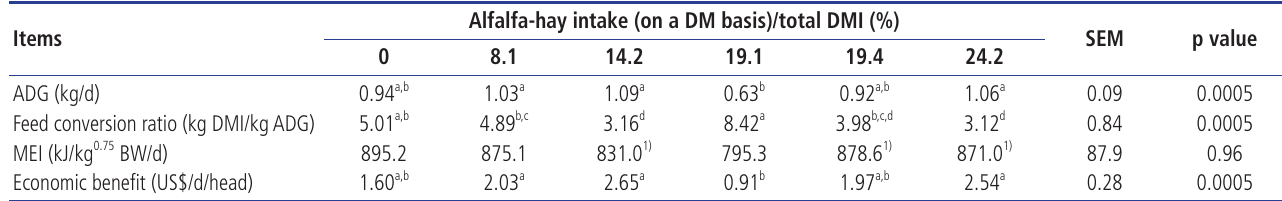
Table 6. Growth performance, energy intake, and economic benefit of Simmental crossbred male calves with different alfalfa-hay intakes (August to September 2015 and July 2016)